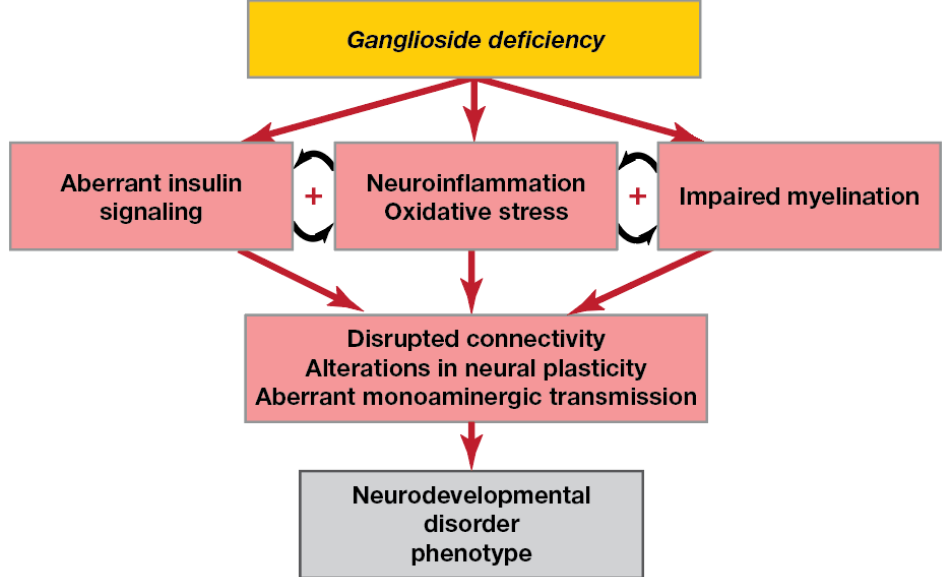
Figure 2. Pathological pathways in brain ganglioside deficiency. Ganglioside deficiency may lead to both neuroinflammation, aberrant insulin signalling and myelination deficits, which are known to be interrelated. Impaired myelination causes neuroinflammation: myelin debris, products of neuron elimination due to necrosis and apoptosis and dysregulation of activity-dependent astrocytes may activate microglia and macrophages. Pro-inflammatory cytokines and dysregulation of glia by inflammation negatively affect myelination. Aberrant signal propagation, axon degradation and neuronal death due to a lack of metabolic support from myelin sheaths disrupt brain connectivity. Additionally, neuroinflammation contributes to alterations in monoaminergic transmission and neural plasticity.